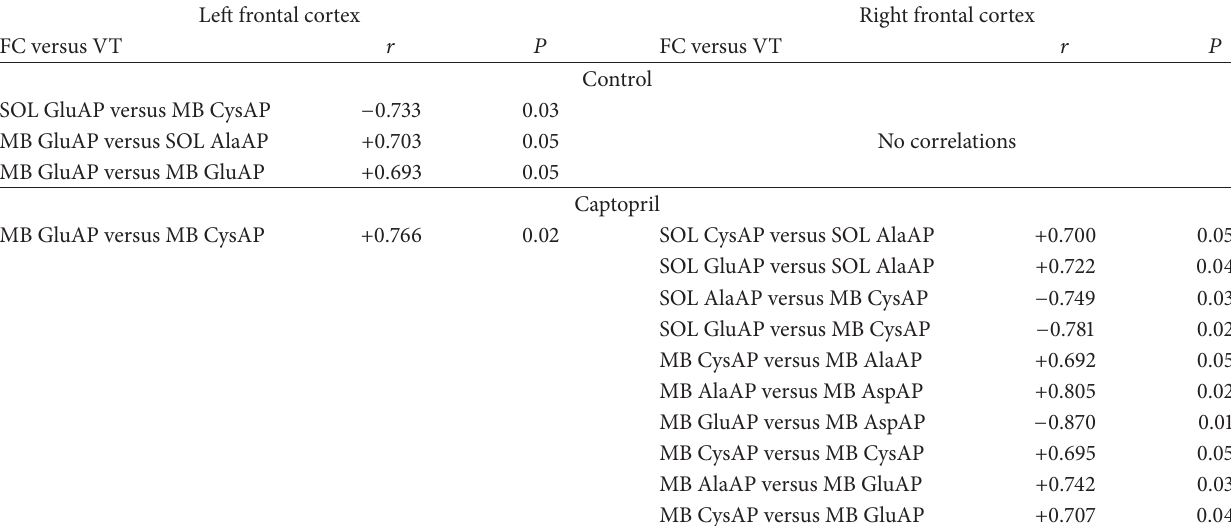
Table 1: Frontal cortex versus